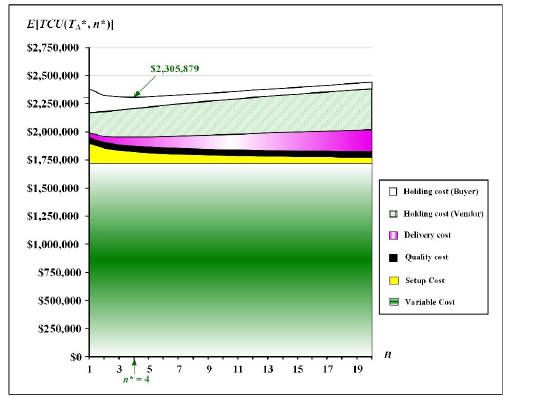
Fig. 17. The delivery frequency n on key cost contributors in E [ TCU ( T A *, n *)]